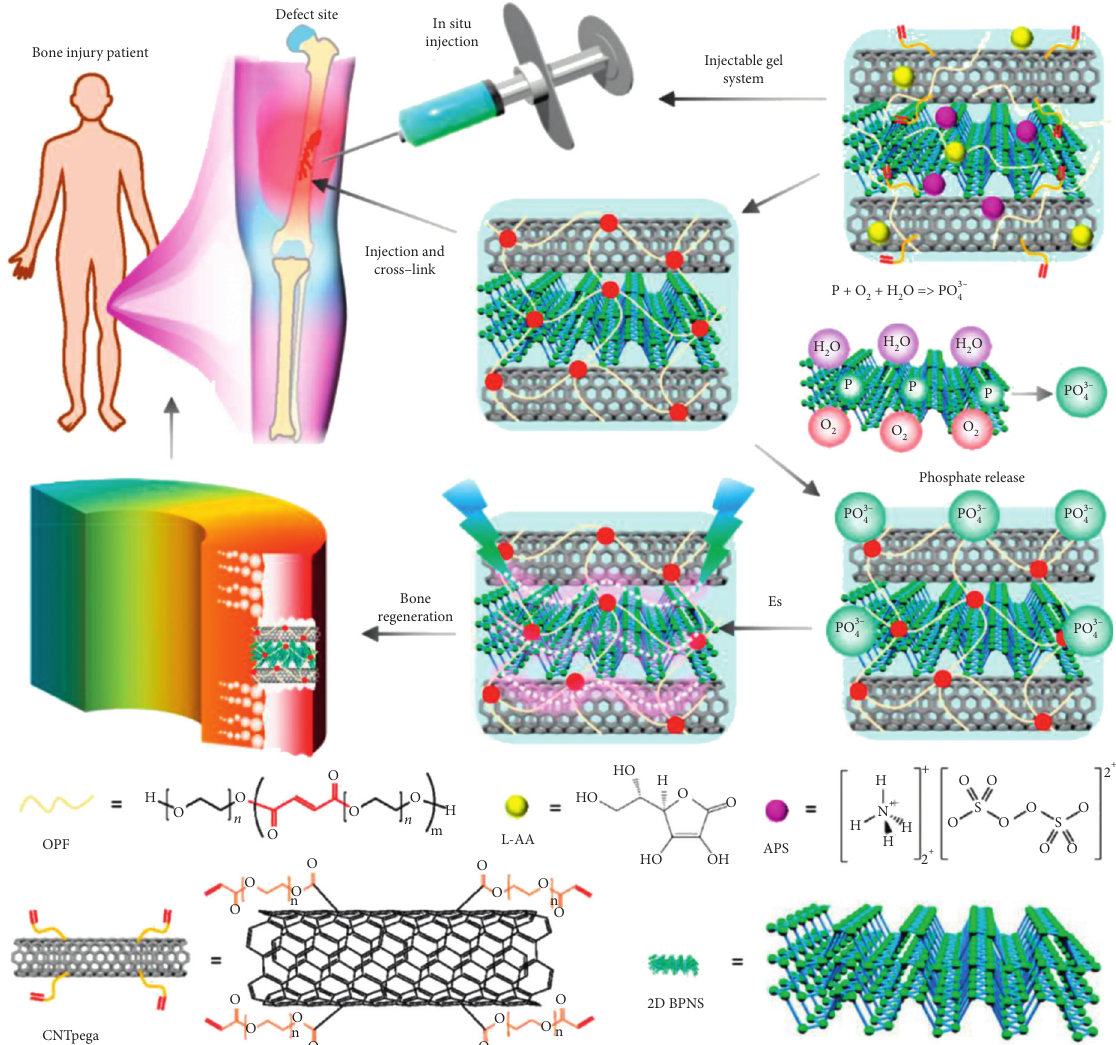
Figure 4: Schematic demonstration of the novel injectable gel with continuous phosphate ion release and electrical responsiveness to promote cell osteogenesis and bone regeneration [4]. Copyright © 2020 American Chemical